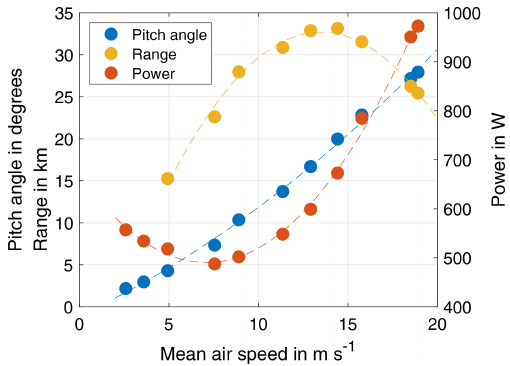
Figure 4. Flight properties on the OPTOkopter for flight speeds be- tween 2 and 18ms − 1